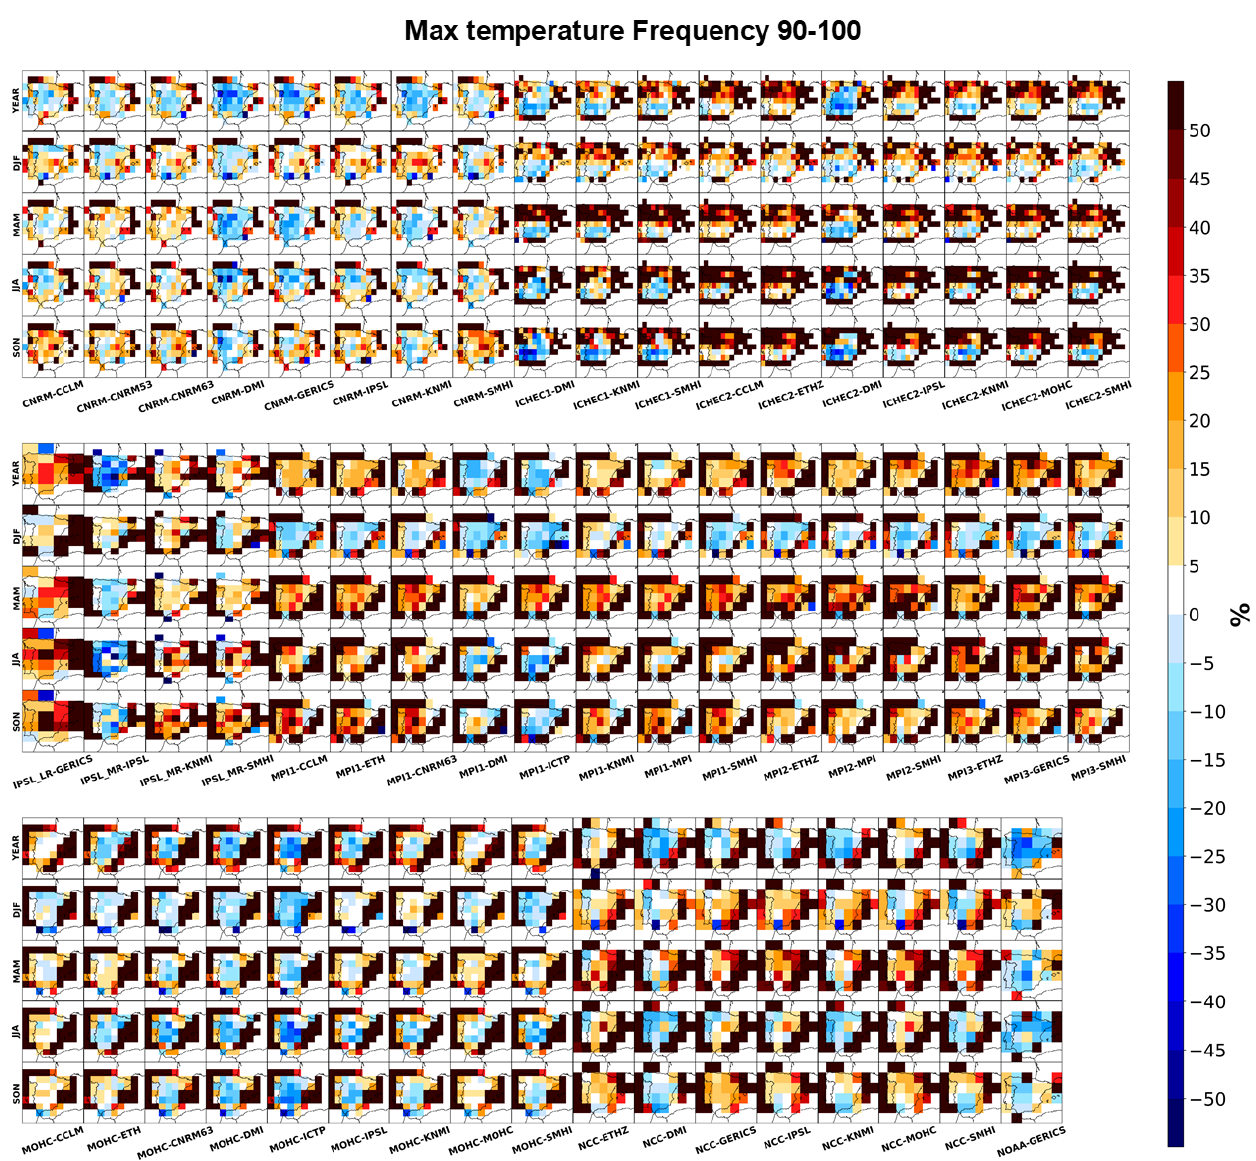
Figure 7. Yearly and seasonal distribution added values (DAVs) of the Iberian Peninsula for the historical (1971–2005) EURO-CORDEX RCMs, with the IGD as a reference for the maximum daily temperature, only considering the values above the observational 90th percentile from maximum temperatures for each GCM grid box. All RCM data were previously interpolated to 0.1 ◦ regular resolution from the observations, while the observations were interpolated into each CMI5 GCM